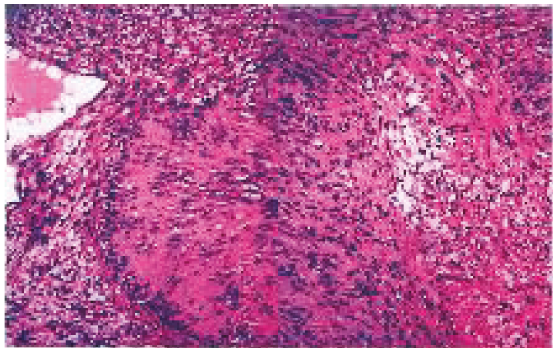
Figure 3: Histopathological examination revealing the presence of Verocay bodies with characteristic hypocelluar areas (Antoni A) with intermittent hypercellular areas (Antoni B) con fi rming the diagnosis of